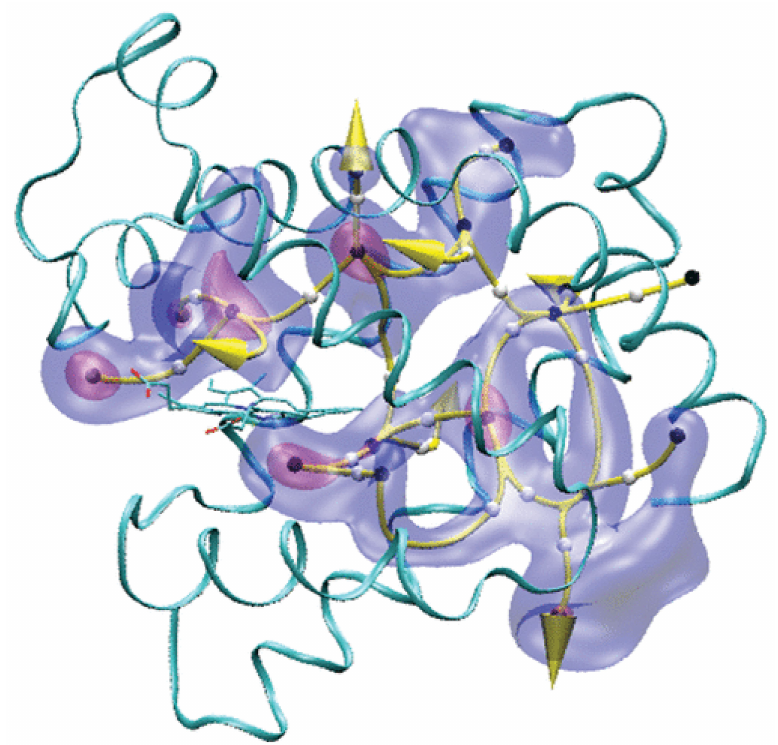
Figure 3. CO migration pathways inside Mb. The yellow curves are MFEPs and identify possible CO routes. Two isosurfaces of the PMF map are shown (red, 2.0 kcal/mol; blue, 5.0 kcal/mol; with respect to the PFM at the Xenon 4 cavity, taken as zero). The white and black spheres represent, respectively, the locations of the energy barriers and the local minima along the pathways. The yellow arrows represent the locations of the CO exits to the solvent. The protein’s backbone is represented as ribbons and the heme as sticks. Reprinted with permission from Ref. [58]. Copyright 2010 American Chemical